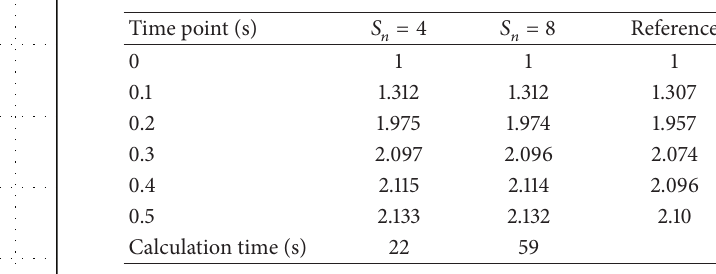
Table 4: Normalized power versus time with different discretization order in TWIGL problem during ramp perturbation.